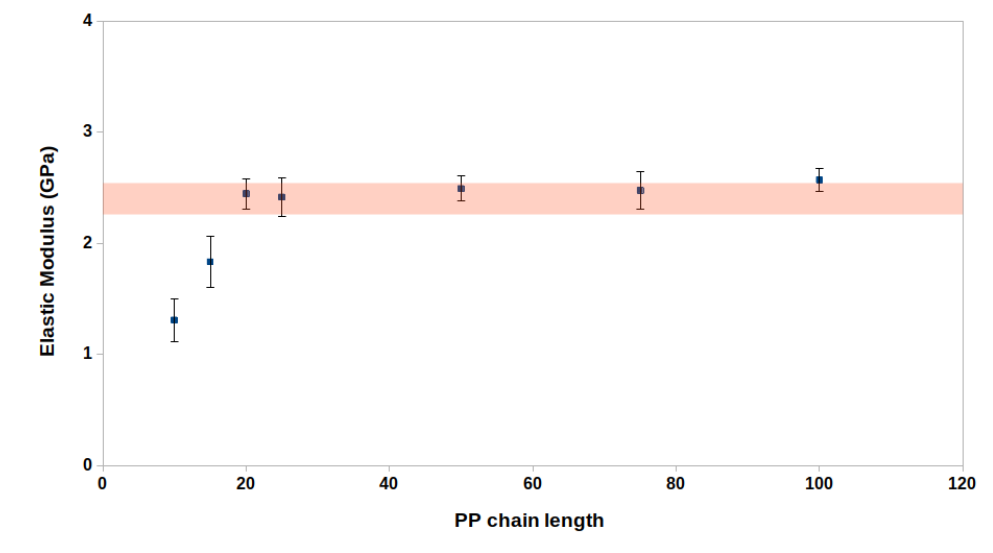
Figure 6. The relationship between PP chain length in terms of monomer units and elastic modulus in the linear regime. The elastic module converges at a chain length of 20 monomer